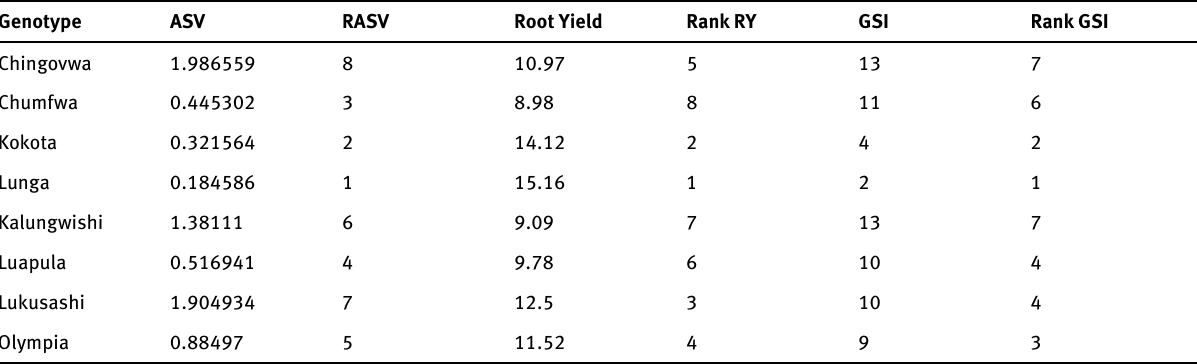
Table 4: Ranked genotype stability indices for sweetpotato root yield